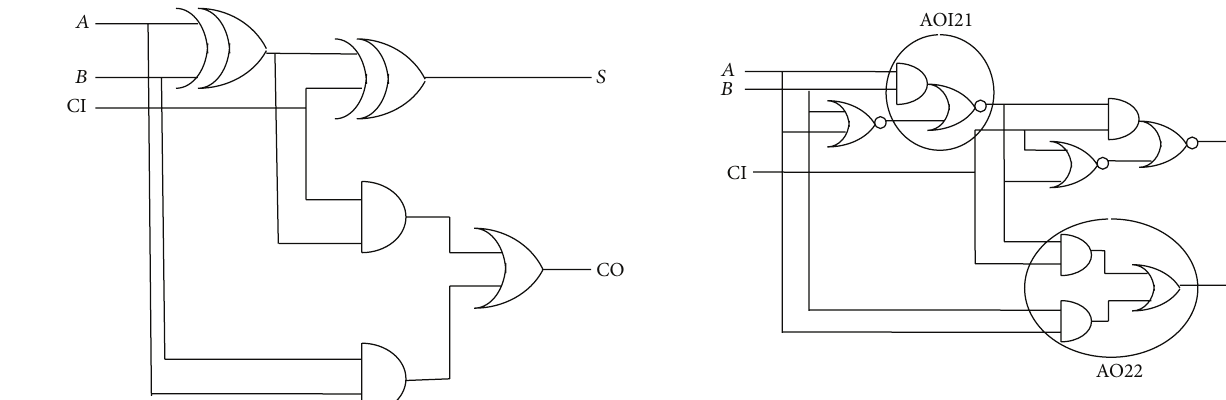
Figure 3: Proposed full adder architecture used in proposed digital filter